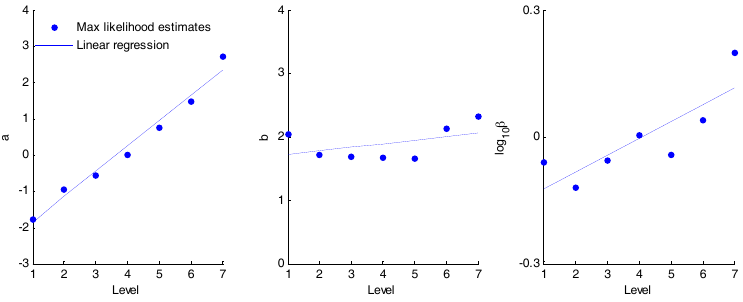
Figure 6. Generalised models of parameters a , b , and log 10 β for the bounded model.